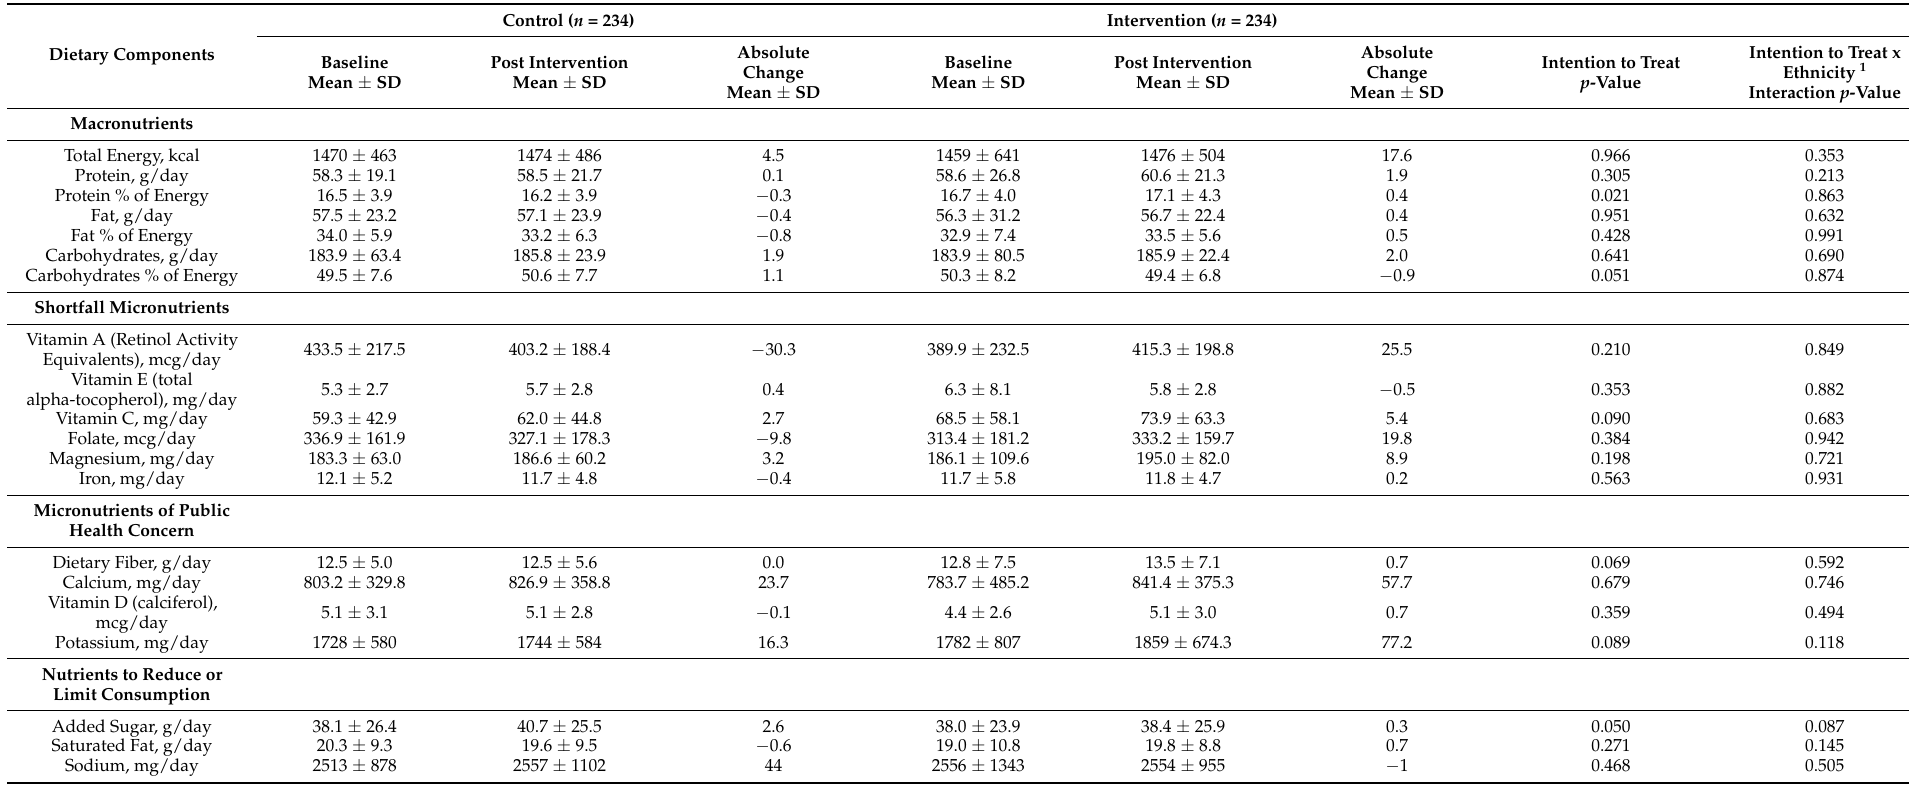
Table 1. Repeated Measures ANCOVA of Intent to Treat Effects of a School-Based Cooking, Gardening, and Nutrition Intervention Macronutrients, Shortfall Micronutrients, Micronutrients of Public Health Concern, and Nutrients to Reduce Consumption in Low-Income Elementary Aged Children.